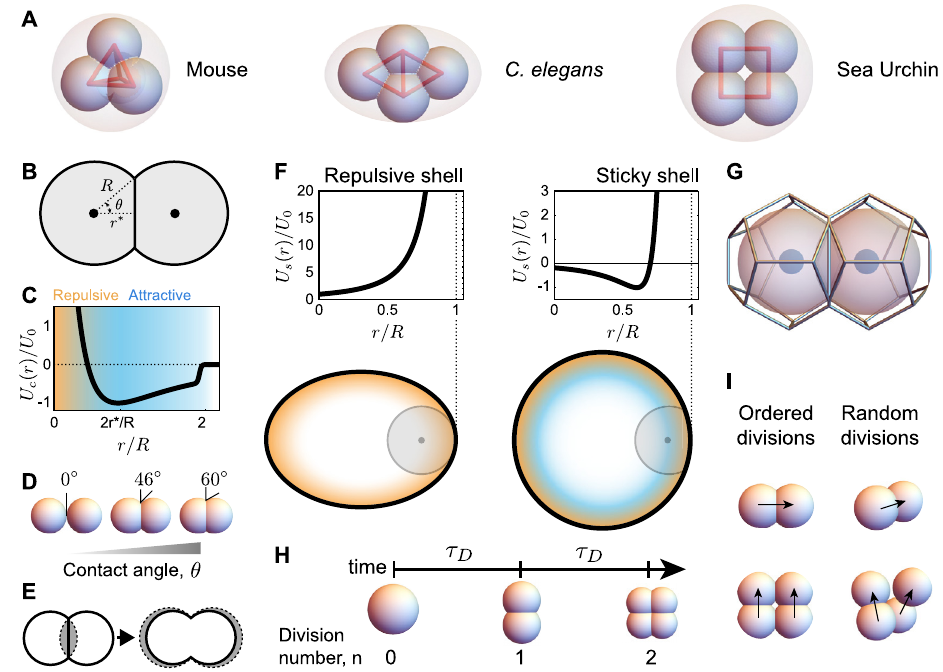
Fig 1. Schematics and definitions of early embryo dynamics. A , Schematic representation of the most common 4-cell embryo arrangements in the mouse (tetrahedron), C. elegans (diamond) and sea urchin (square). Blastomeres (small spheres) are confined by the surrounding confining envelope (pink; vitelline envelope, hard chitinous egg shell, or hyaline layer, respectively). B , Abstraction of two cells in contact, depicting the cell radius R , equilibrium distance r � and contact angle θ . C , Cell-cell interaction potential U ( r ). D , Examples of cell configurations for varying contact c angles. E , Effective volume correction: the overlapping volume (gray, left) is added to each cell by increasing its radius to match the actual cell volume. F , Examples of interaction potentials, U ( r ), of a cell with repulsive (left) and sticky s (right) confining shells. Repulsive and attractive regions are shown in orange and blue tones, respectively. G , 3D Voronoi tessellation of neighboring cells (Methods). H , Definition of time between divisions τ and division cycle n . I , D Ordered divisions indicate that cells follow specific division rules. In contrast, the cell division axis is randomly oriented for random